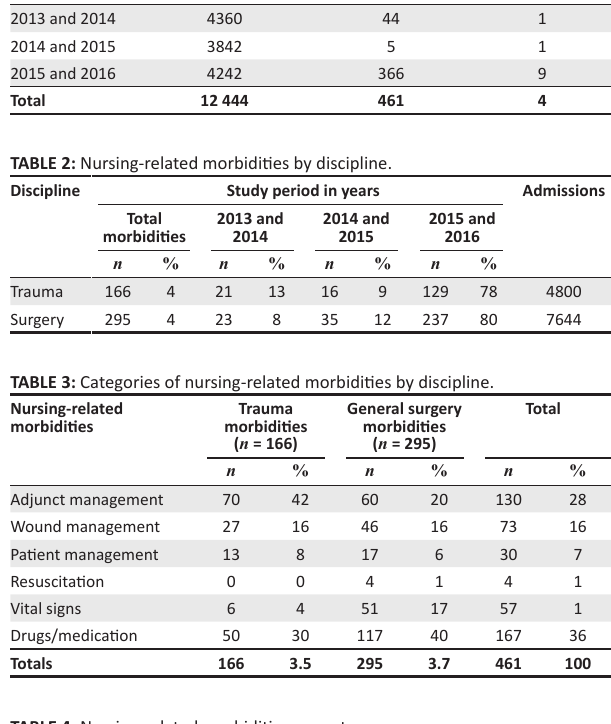
TABLE 4: Nursing-related morbidities per category per years.